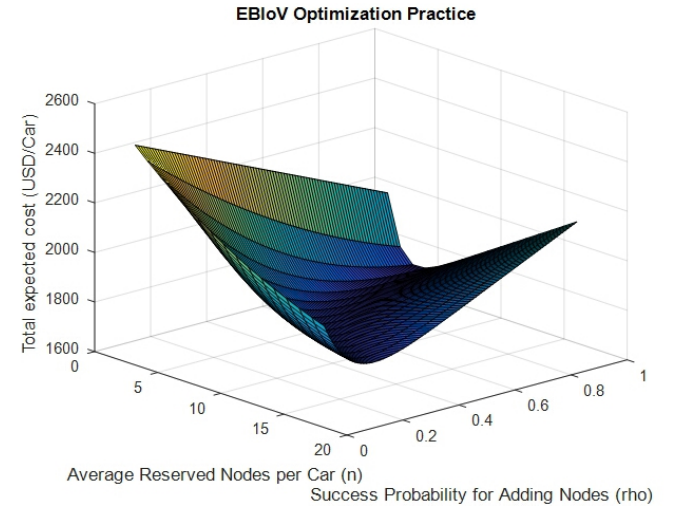
Figure 3. Optimization Example for the